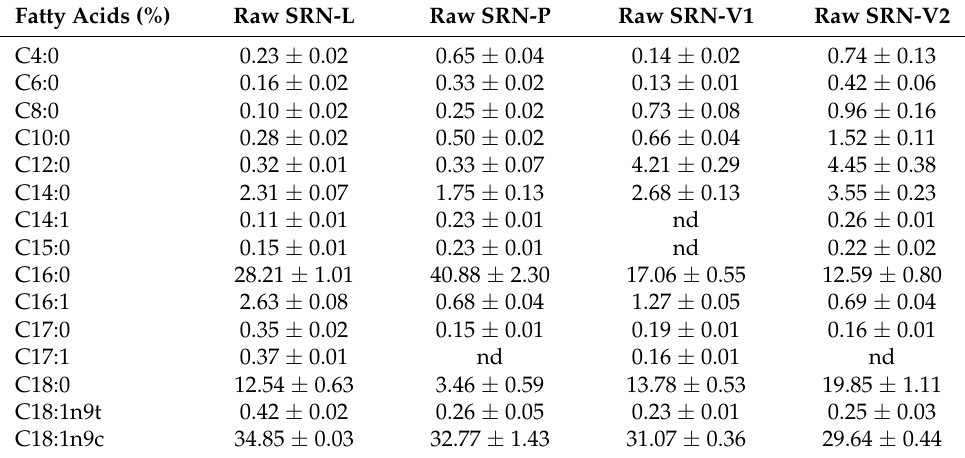
Table 5. Fatty acid compositions (mean ± SD) of the raw SRNs produced with the different fat blends, L, P, V1, and